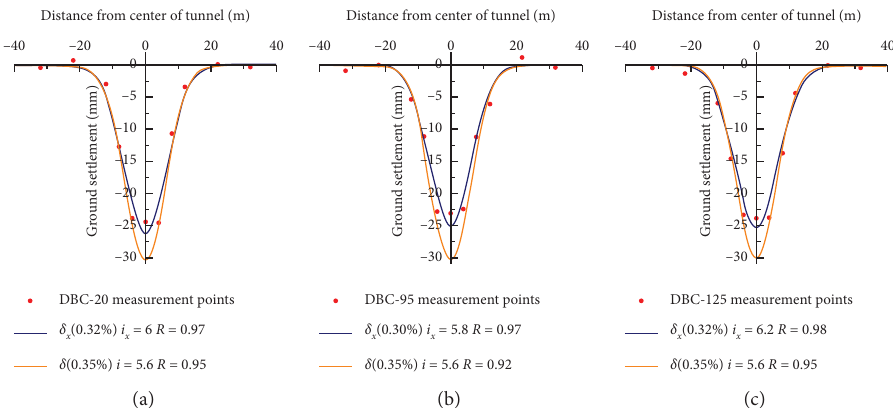
Figure 16: Field measurement and Peck formula optimization of shield ground surface settlement: (a) DBC-20. (b) DBC-95. (c) DBC-125.